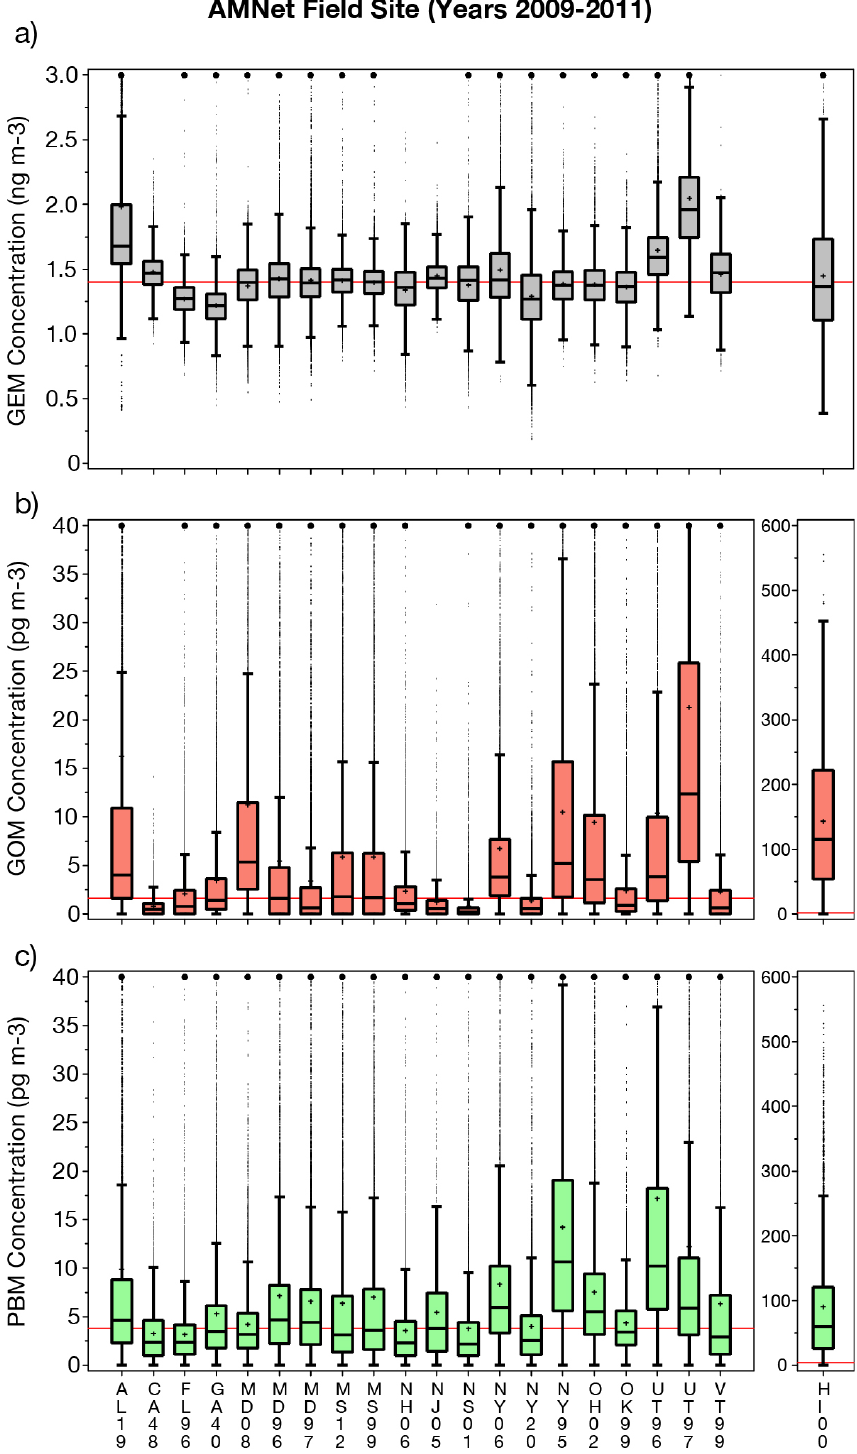
Fig. 2. Box-and-whisker plots of gaseous elemental mercury (GEM, ngm − 3 , a ) and for gaseous oxidized and particulate-bound mercury (GOM and PBM 2 . 5 , pgm − 3 , b and c ) observations for all each site for years 2009 to 2011. Each box includes the median (midline), mean ( + ) , 25th and 75th percentiles (box edges), 5th and 95th percentiles (whiskers), and individual values outside these limits (dots). Values above 3.0ngm − 3 and 40pgm − 3 , respectively, are not shown (large dots). The respective medians of all observations are shown for reference (red lines, without HI00 for GOM and PBM 2 . 5 )